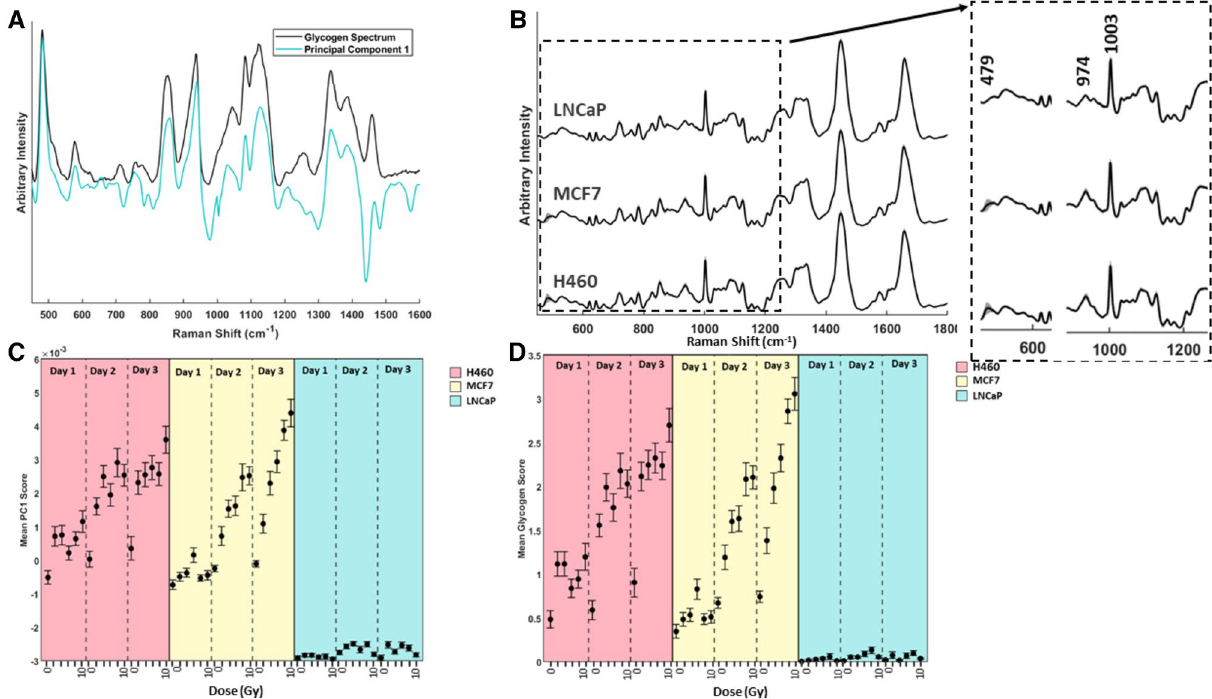
Figure 2. (A) RS of pure glycogen (black) overlaid with principal component 1 (green). (B) Average RS obtained from all days and doses including unirradiated controls for H460 cells, MCF7 cells and LNCaP cells. Shadow spectrum represents + / − 1 standard deviation at each wavenumber. The greatest deviation in H460 and − 1 MCF7 cells is visible at 479 cm , which can be attributed to the change in glycogen content with respect to day and dose of radiation received. Inset spectra highlight the larger standard deviation (shadow spectrum) from − 1 − 1 − 1 the mean at 479 cm , 974 cm and 1003cm for MCF7 and H460 cells compared with a smaller standard deviation observed in LNCaP cells. (C) Mean PC1 scores for H460 cells (pink), MCF7 cells (yellow) and LNCaP cells (blue) for doses 2–10 Gy on days 1–3 post irradiation. Error bars represent + / − 1 standard error. (D) Mean glycogen scores for H460 cells (pink), MCF7 cells (yellow) and LNCaP cells (blue) for doses 2–10 Gy on days 1–3 post irradiation, obtained using the GBR-NMF model. Error bars represent + / − 1 standard error.